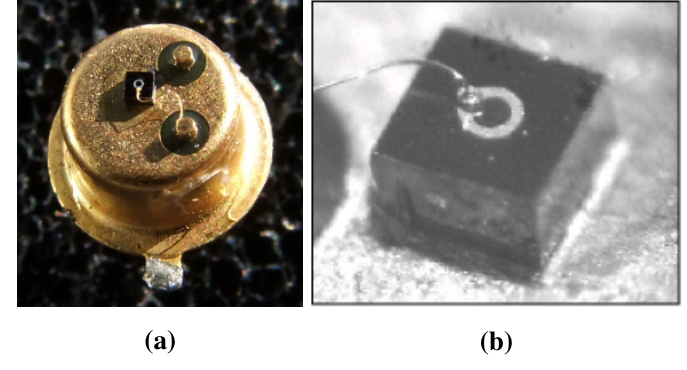
Figure 3. ( a ) The picture of K14 SPAD chip mounted onto a standard TO (Transistor Outline) package. The anode is at the bottom of the chip mounted to the package via an electrical conductive adhesive [9]; ( b ) The detail of the chip active area diameter of 100 µm with wire bonding of the diode cathode. The sensitive area is inside the circle formed by cathode metal contact